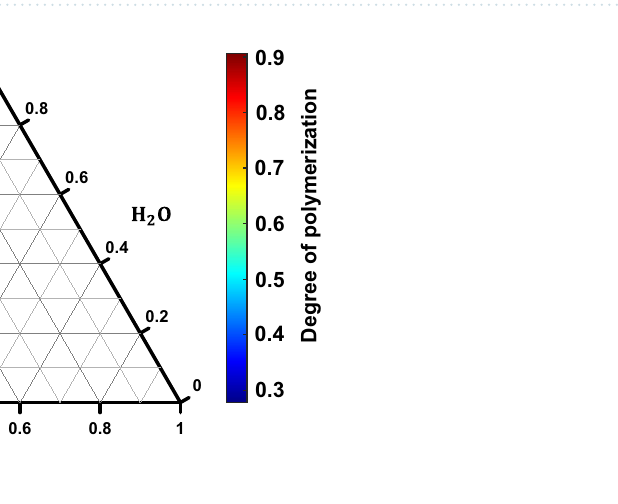
Figure 3. Ternary diagram showing the influence of CaO–SiO 2 –H 2 O content on the degree of